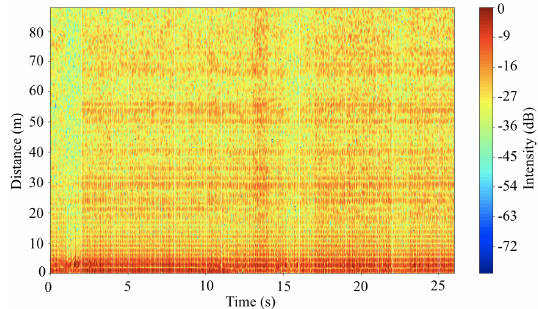
Figure 13. Background noise measured through the radar system at Cumberland park parking